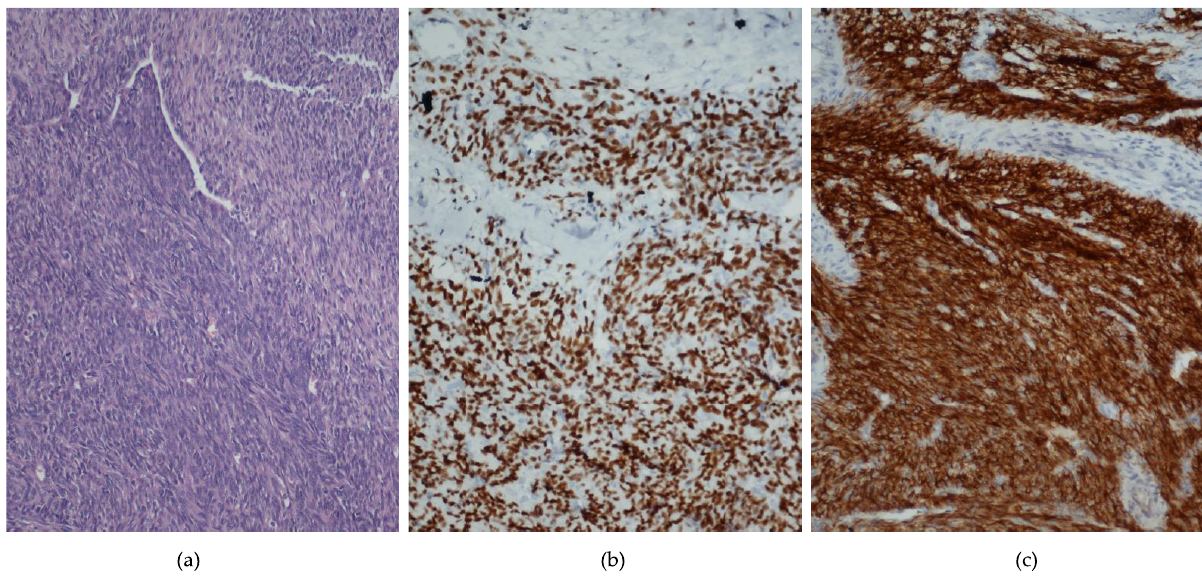
Figure 1. A monophasic PRSS. ( a ) Hematoxylin & eosin stain (x200). ( b ) TLE-1 stain (x200). ( c ) CD56 stain (x200) .